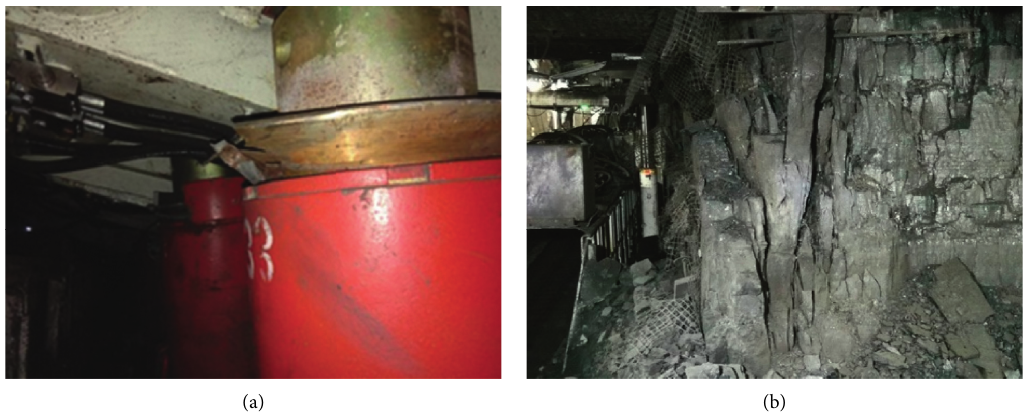
Figure 1: Dynamic load hazards in open face area: (a) shield collapse from roof fall; (b) face failure from excessive roof-to-floor